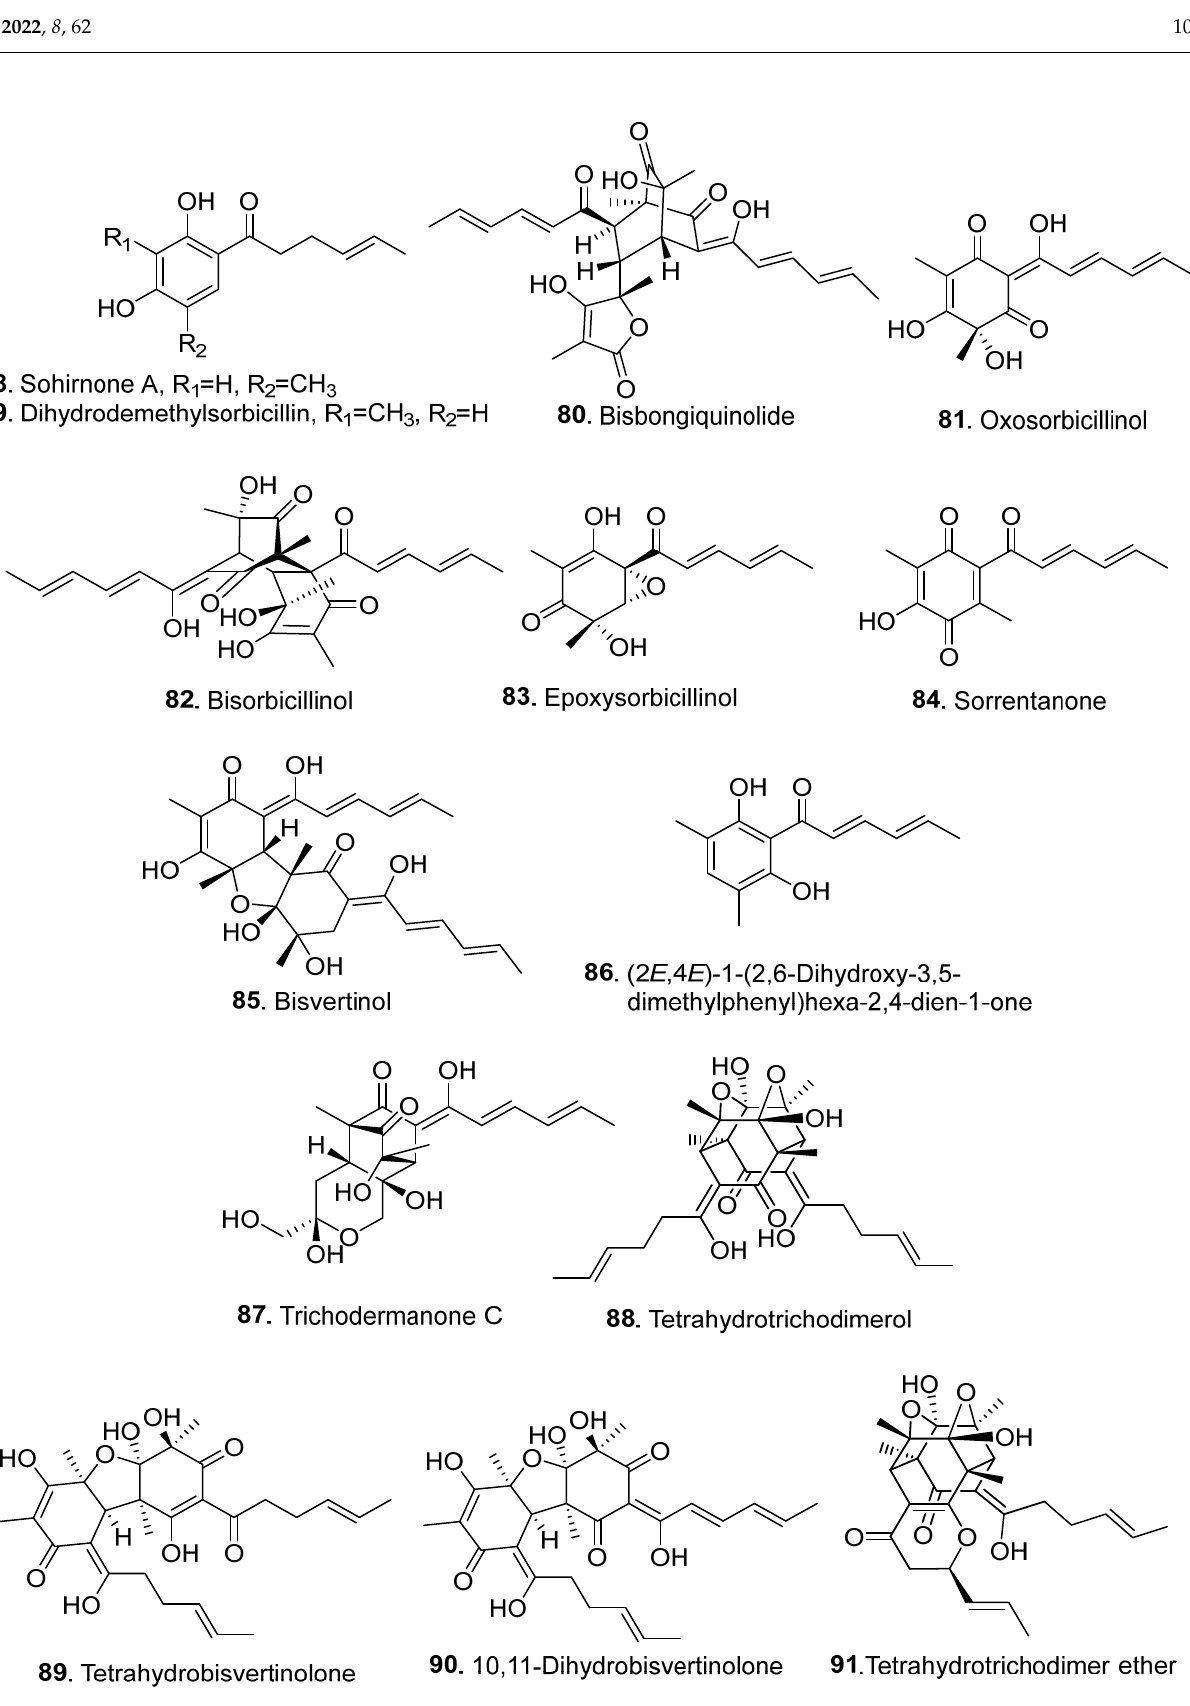
Figure 6. Structures of some sorbicillinoids ( 74 – 91 ) discovered before 2016 with newly revealed biological activities.